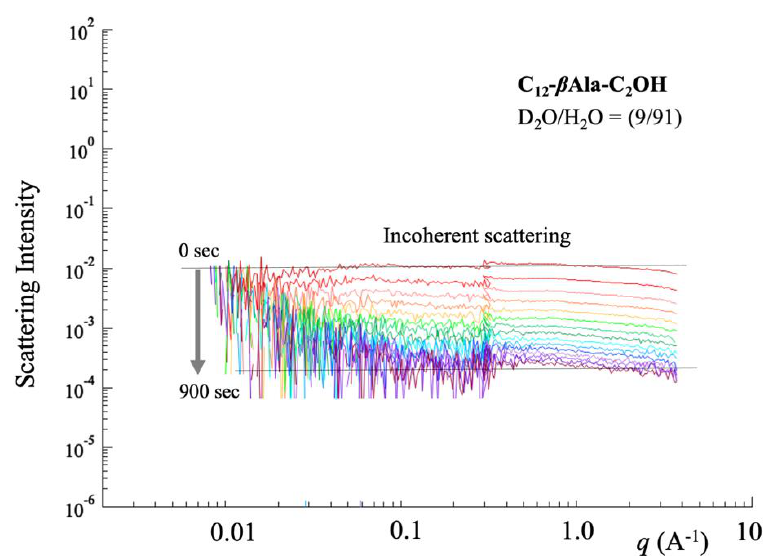
Figure 12. Time-resolved incoherent SANS obtained for the C 12 – EtOH – β Ala solution of mixed water (H 2 O/D 2 O (9/91, vol/vol)), which exhibited q- independent scattering (incoherent scattering from hy- drogen). The dotted lines are guides for the eye.